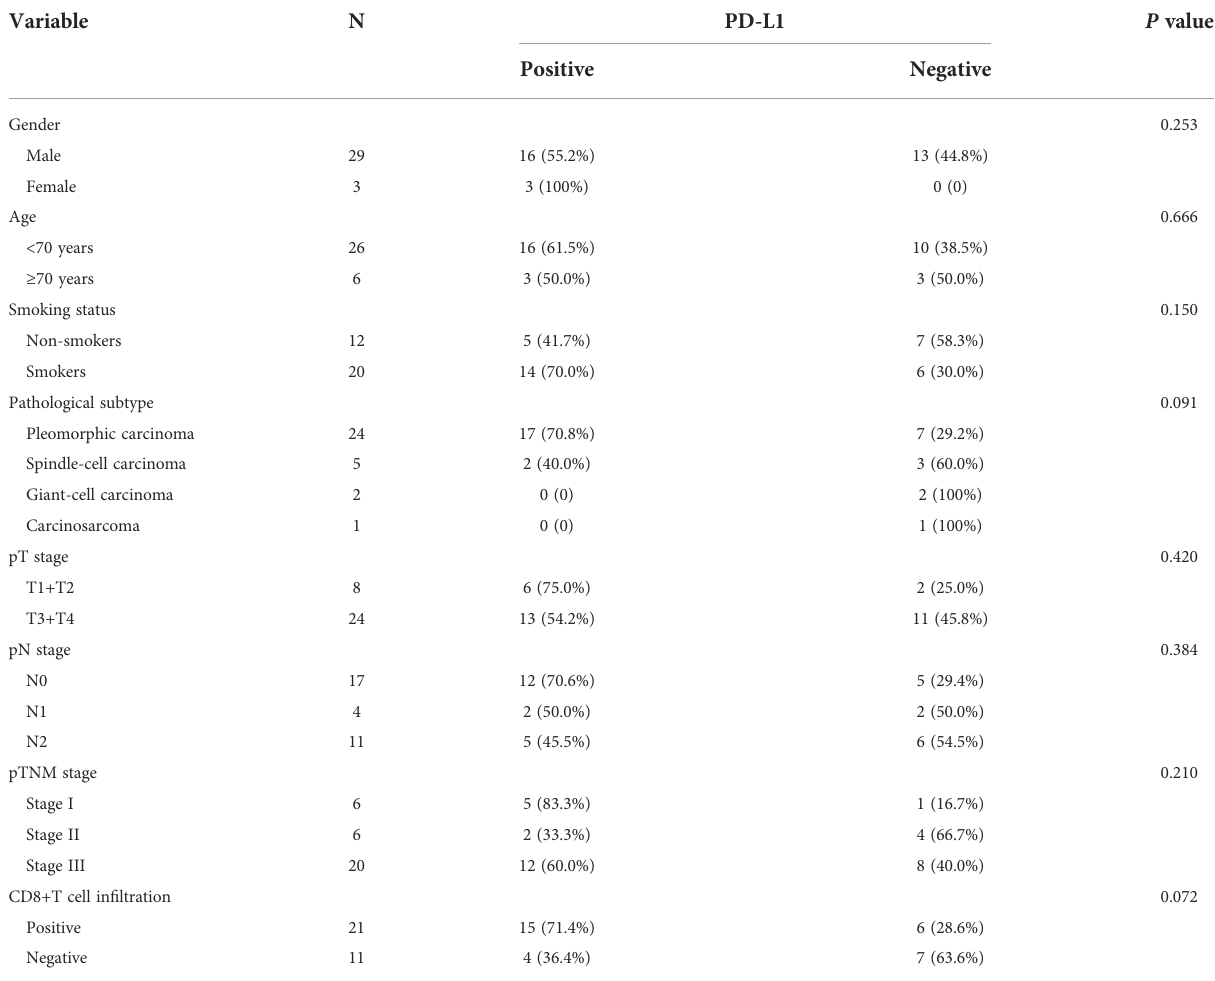
TABLE 3 Correlation between PD-L1 expression and clinicopathological features in